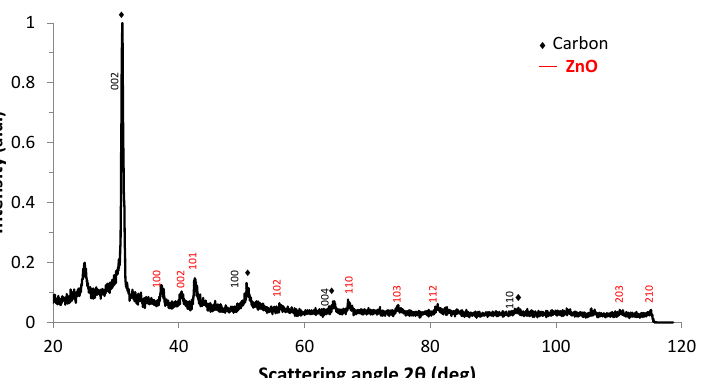
Figure 9. X-ray di ff raction pattern of GrZnO sample obtained using Cobalt-K α radiation ( λ = 1.7889 Figure 9. X-ray diffraction pattern of GrZnO sample obtained using Cobalt-K  radiation (  = 1.7889 Å ).